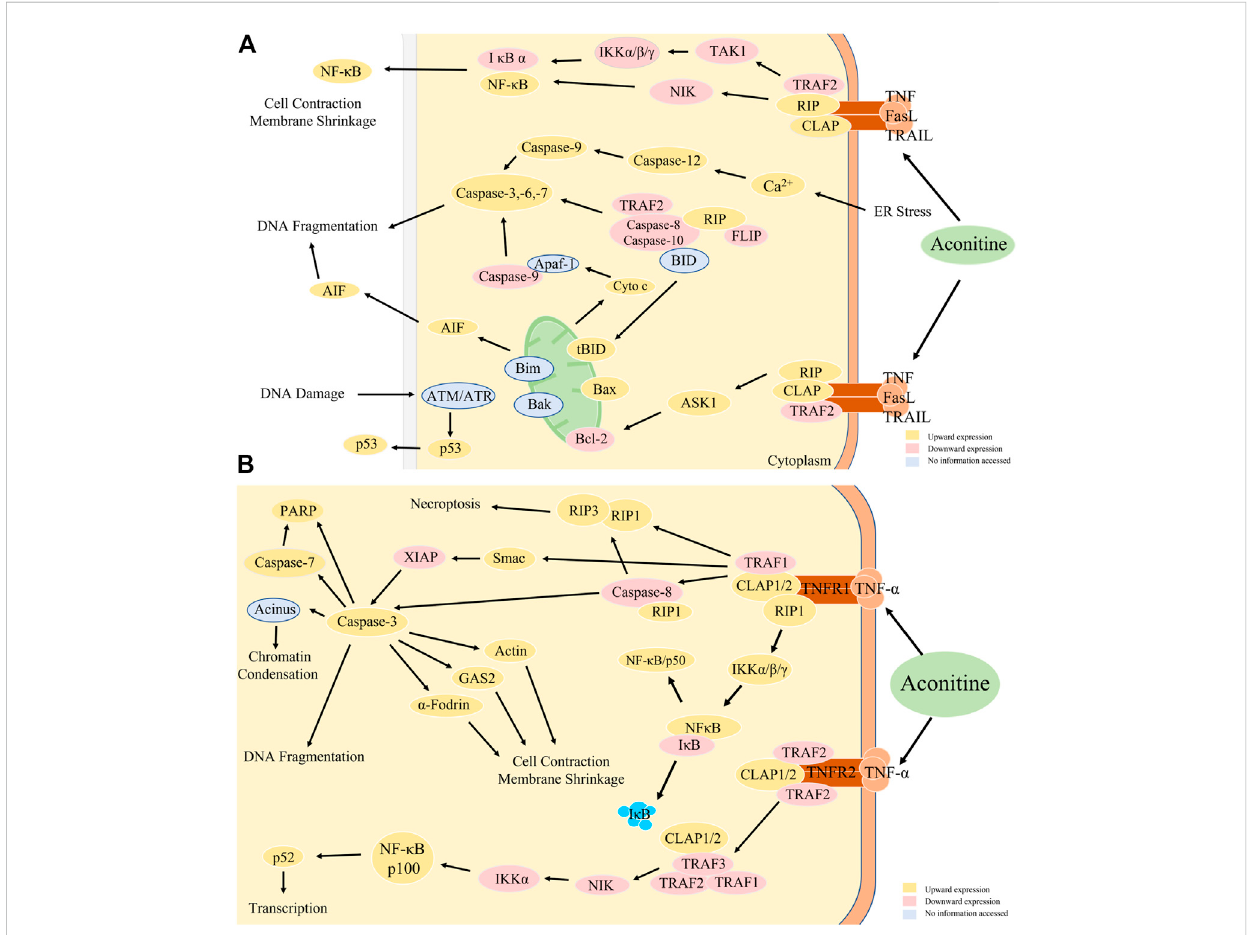
FIGURE 11 (A) Anti-tumormechanismofaconitine. (B) NF- κ Bsignalpathdiagram.TRAF2,TNFreceptor-associatedfactor2;NIK,NF- κ B-induciblekinase;TAK1, human transforming growth factor kinase 1. IKK, inhibitor of kappa B kinase, kappa B inhibitory factor kinase; FLIP, FLICE inhibitory protein, apoptosis inhibitory protein; Itch (AIP4), atrophin 1 interacting protein 4; RIP, RNA binding protein; ASK1, apoptosis signal-regulated kinase 1; JNK, c-Jun amino- terminal kinase; AIF, apoptosis-inducing factor; BID, carboxy-terminal fragment; ATM, Ataxia-telangiectasia mutated proteins; ATR, Automatic Target Recognition; p53, human tumor suppressor gene; CLAP, Carbohydrates, Lipid, Nucleic Acid, Protein; I κ B, inhibitor of NF- κ B; RelA, RELA proto- oncogene, NF- κ B subunit; Smac, second mitochondria-derived activator of caspases; GAS2, Recombinant Growth Arrest Speci fi c Protein 2; a-Fodrin, Anti-alpha-cytosolic protein; XIAP, X-linked inhibitor of apoptosis protein; PARP, poly ADP-ribose